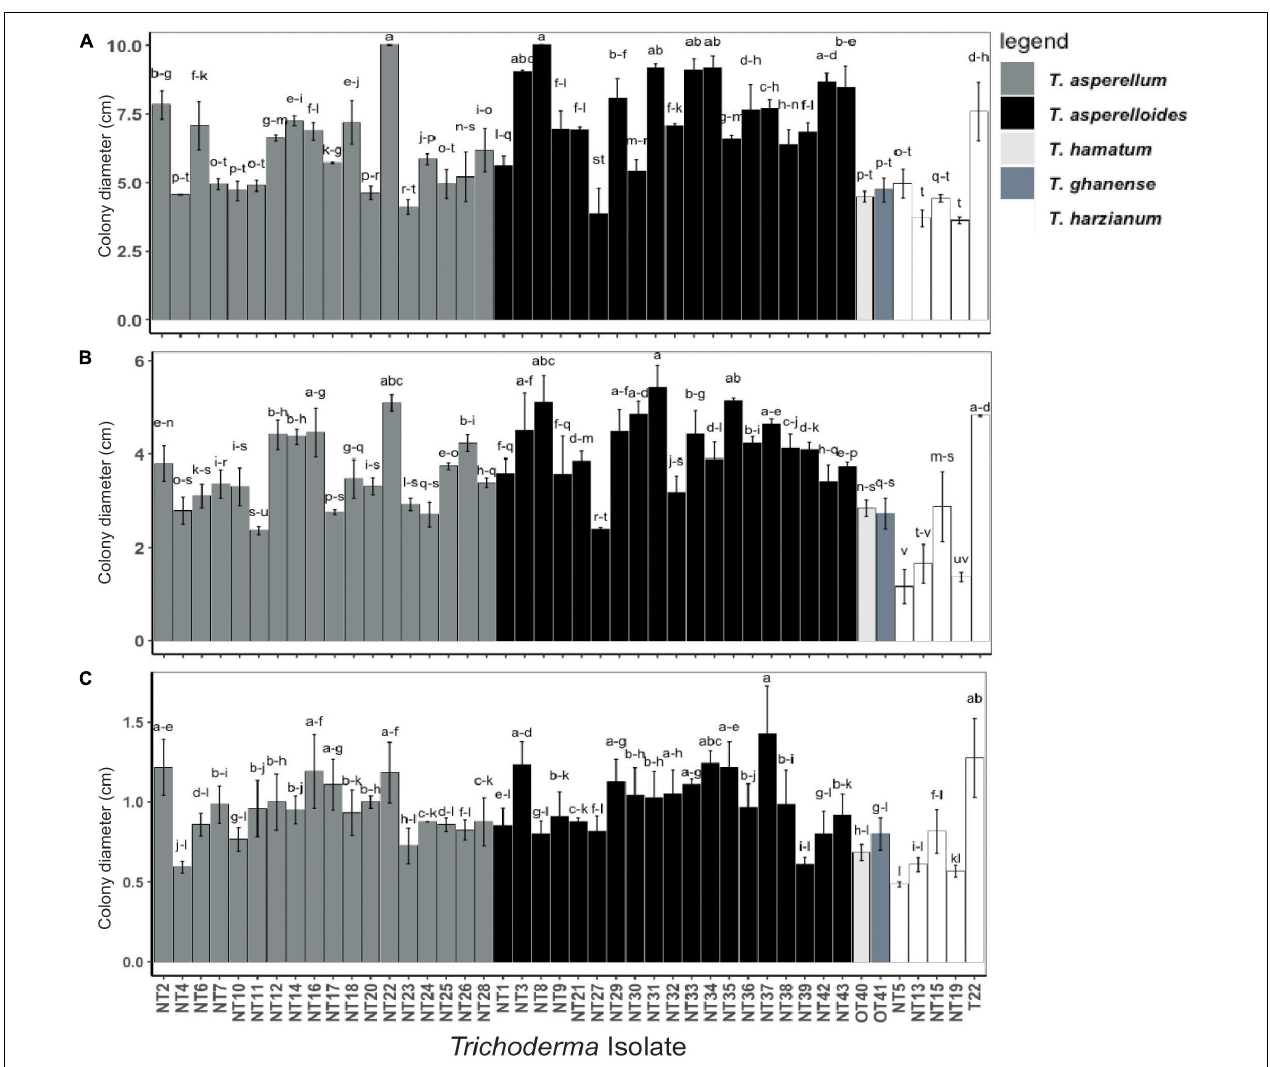
FIGURE 2 | Radial mycelial growth of Trichoderma isolates grown in media at different matric water potentials: (A) –2.8 (cid:57) , (B) –4.8 (cid:57) , and (C) –8.5 (cid:57) ; the matric potentials were generated by adding 400, 600, and 800-g PEG into 1-l PDA respectively. Radial growth of the Trichoderma colony (cm) was measured along the plate diameter after 7 days. Values represent the mean growth ± SE of isolates from two trials each performed in triplicate. Isolates with different superscripts are significantly different according to Fisher LSD test ( P < 0.05). Bar colors represent the species of tested